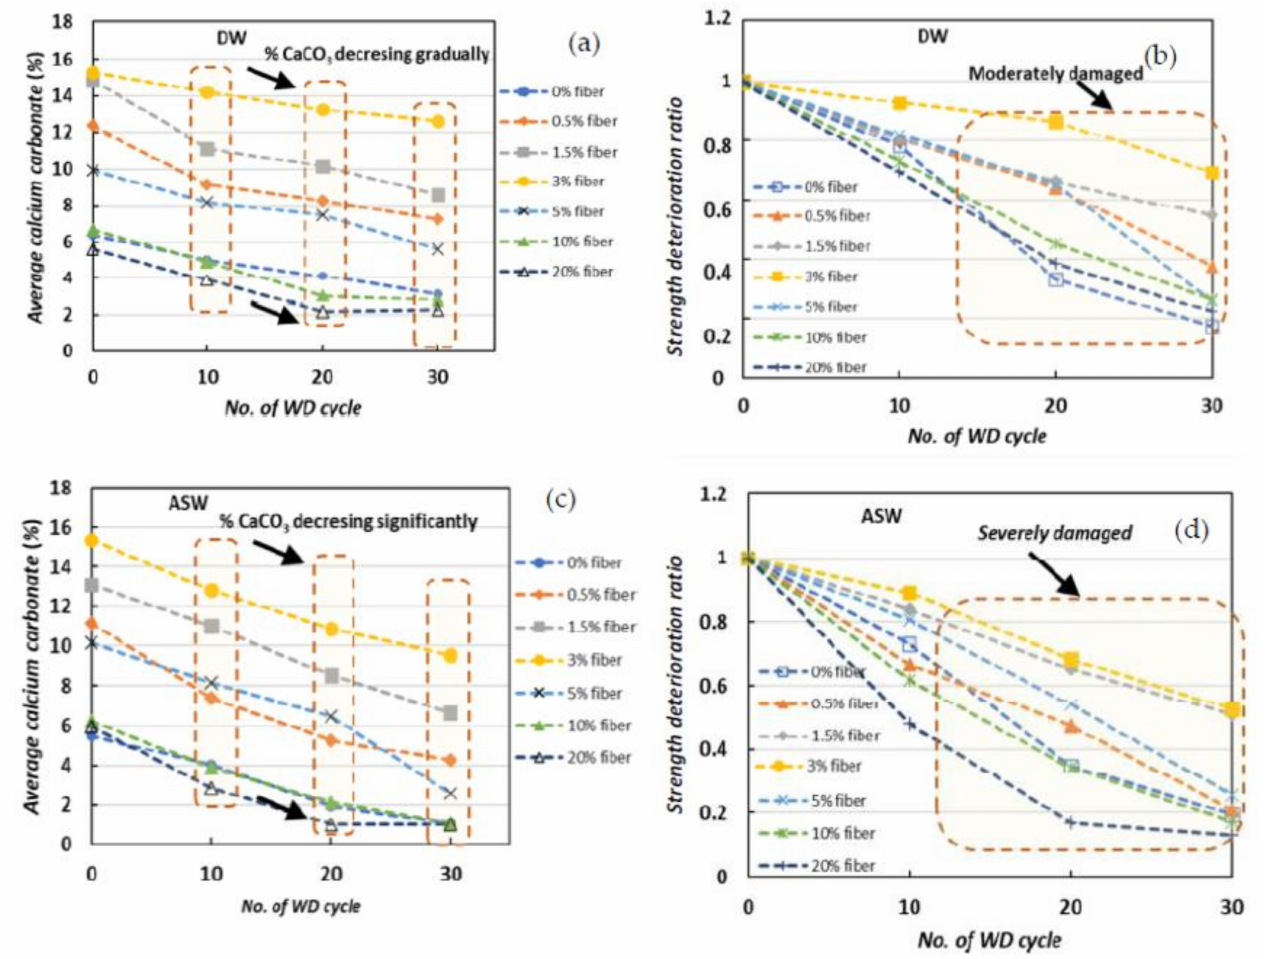
Figure 6. The average calcium carbonate (%) of the samples treated with ( a ) DW and ( c ) ASW, and the strength deterioration ratio in ( b ) DW and ( d ) ASW after the exposure to cyclic WD tests. However, from the cyclic WD tests (using the DW and ASW), it was clearly indicated that only MICP-treated samples underwent acute mechanical deterioration (around 60%) during the ASW tests, and that the addition of fiber significantly improved the strength deterioration ratio (by around 40–50%). This overall investigation (Figure 6) suggested that the mechanical deterioration occurred more prominently early in the WD process